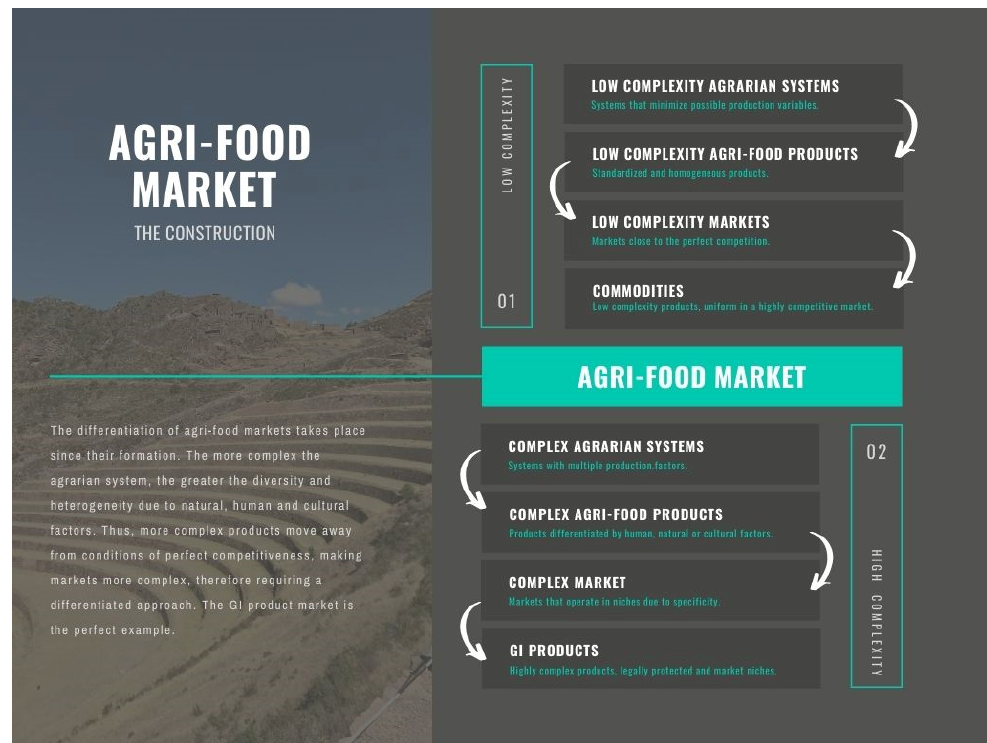
Figure 1. Opposing chains of agri-food market construction.